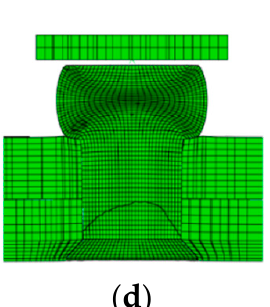
Figure 1. Riveting deformation process: ( a ) stage 1 of riveting process; ( b ) stage 2 of riveting process; ( c ) stage 3 of riveting process; ( d ) stage 4 of riveting process.